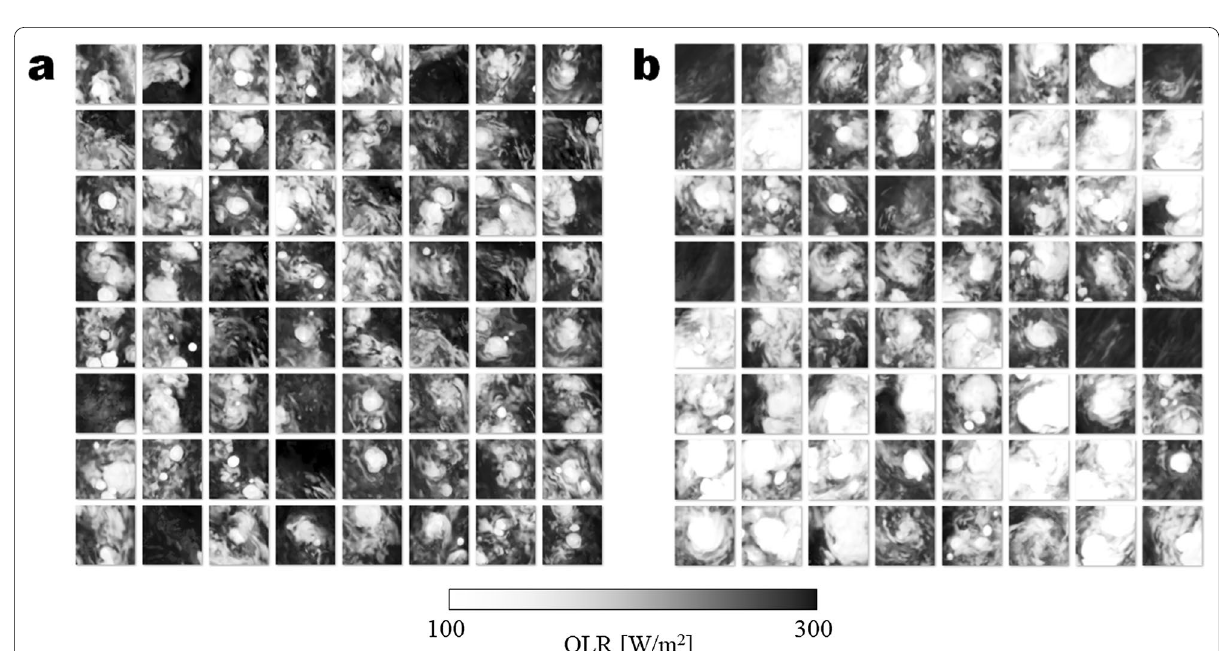
Fig. 7 Examples of a false negatives and b false positives for the test data by all top four